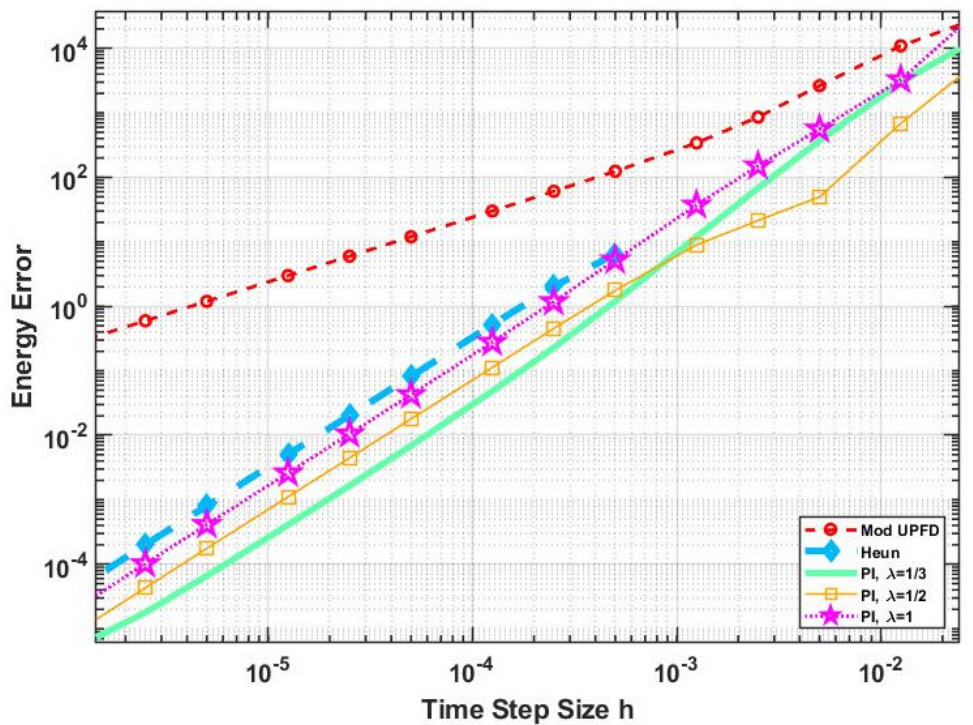
Figure 5. Energy errors as a function of the time step size for the second (very stiff) system, in the case of the UPFD Algorithm 2, the Heun method and the new PI algorithms. Table 2. Comparison of different algorithms for the very stiff system of ten thousand